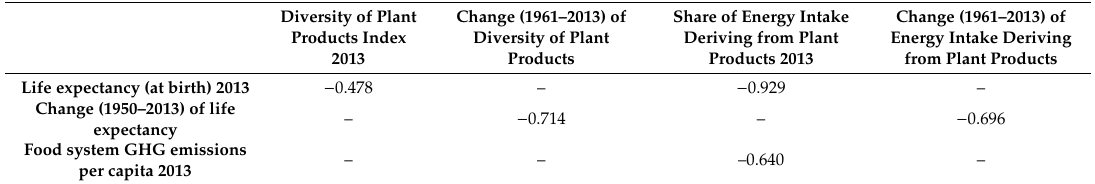
Table 1. Pearson correlation coe ffi cients between various measures of diet sustainability, life expectancy and GHG food system